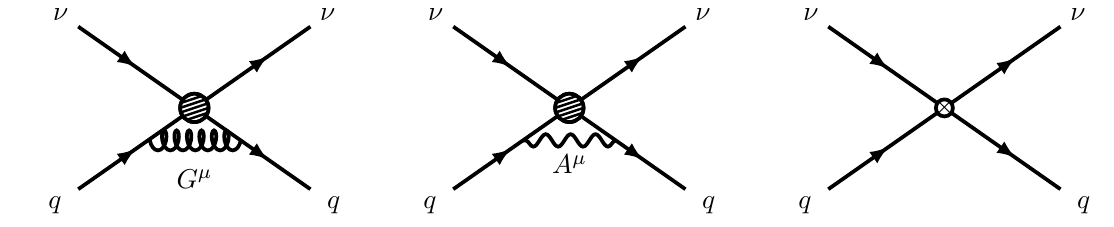
Figure 8. One-loop vertex corrections and counterterm for NC